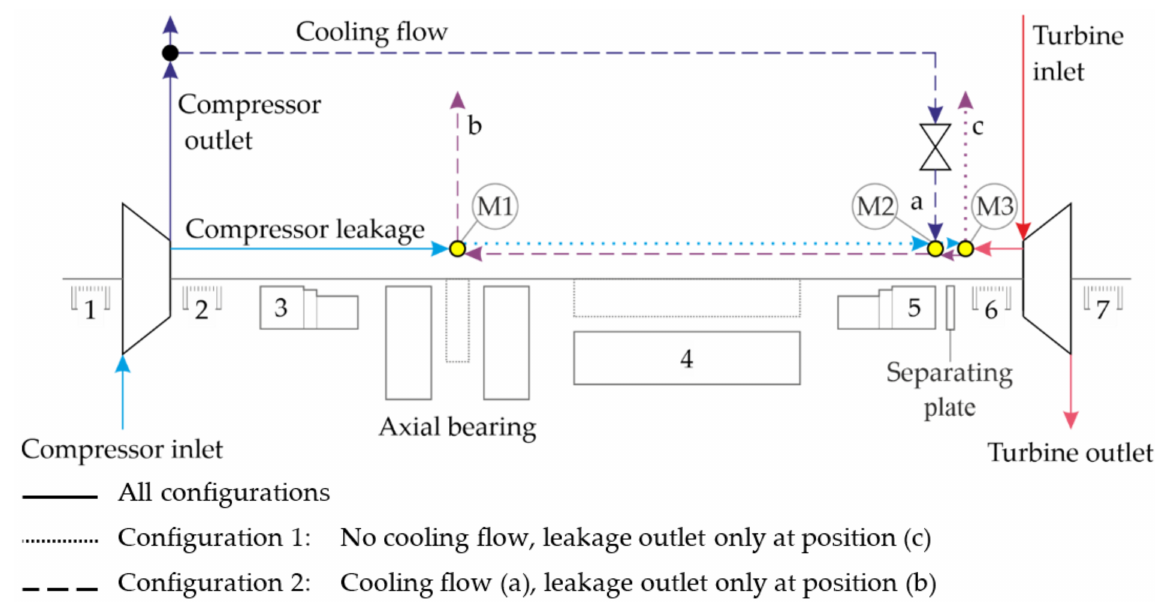
Figure 3. Simplified scheme of CO 2 two configurations of flow paths inside sCO2-HeRo M TAC with labyrinth seals 1, 2, 6, 7, radial magnetic bearing clearance 3, 5 and generator cavity 4 (colors according to Figure